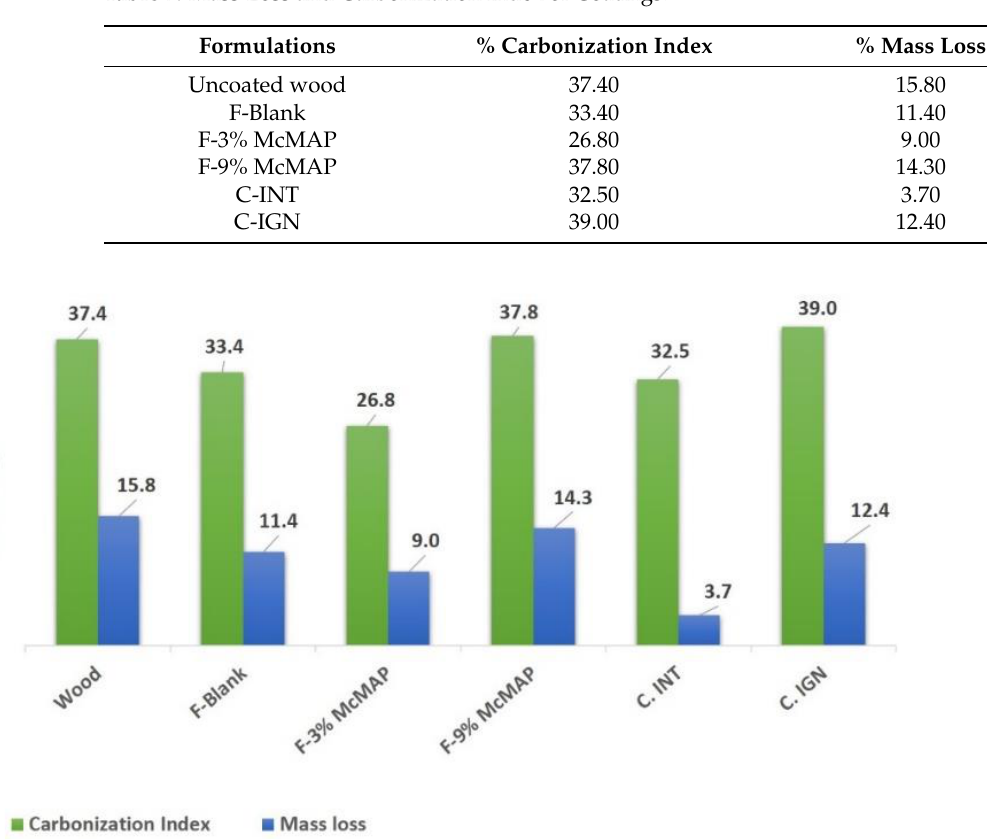
Table 7. Mass Loss and Carbonization Index of Coatings.